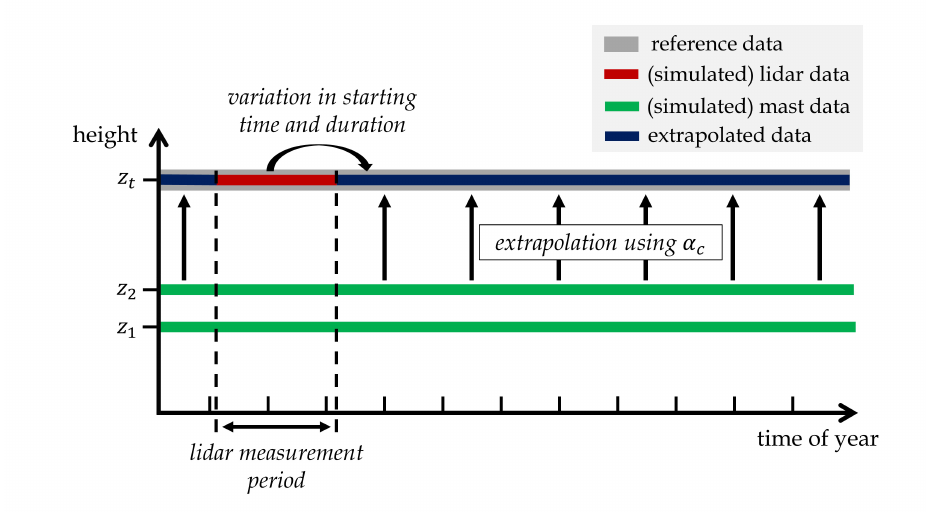
Figure 2. Methodology of the selection of the lidar measurement period and extrapolation. α c is derived using the mast data at heights z 1 , z 2 and the lidar data at the target height z t during the lidar measurement period (red). During the extrapolation period, the mast data are extrapolated from z 2 to z t . The extrapolated data (blue) then are merged with the lidar data. Finally, the resulting time series is compared to the reference data at z t